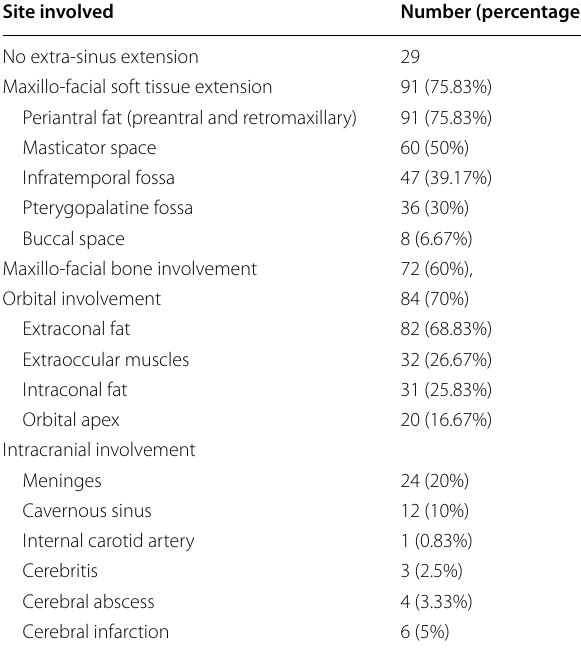
Table 2 Various sites of extra-sinus involvement Site